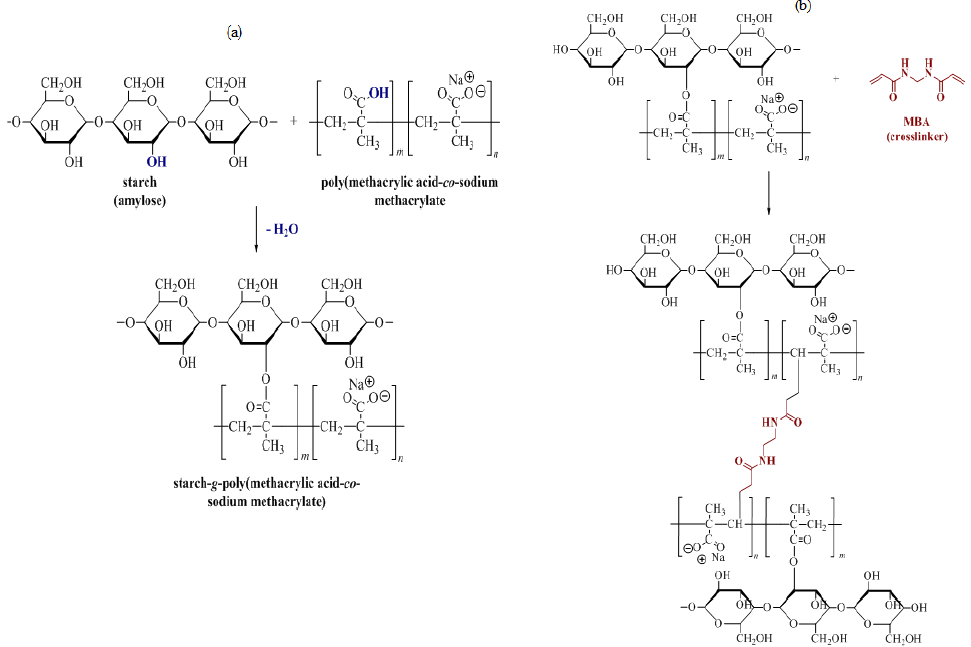
Figure 2. Synthetic procedures for S-SAP: ( a ) reaction of starch with poly(methacrylic acid-co-sodium methacrylate), ( b ) proposed cross-linking of grafted starch polymer.